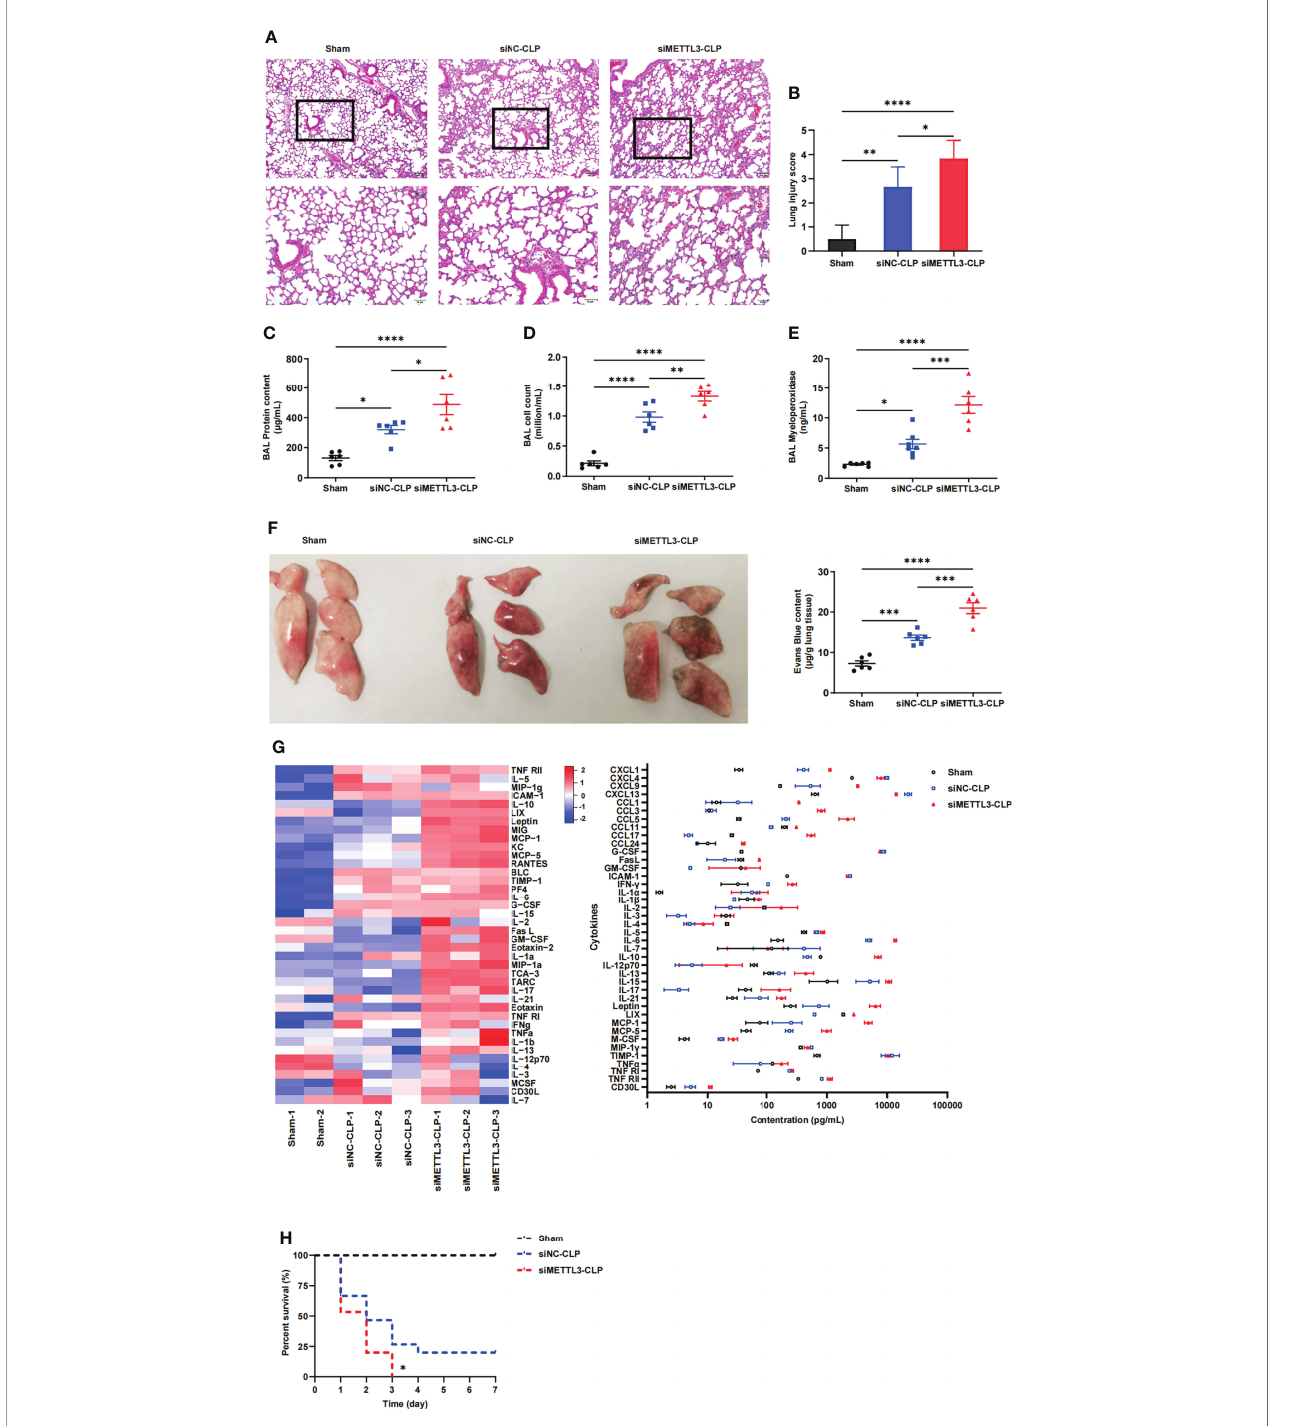
FIGURE 2 | METTL3 deletion exacerbates lung endothelial injury in CLP models. (A) Hematoxylin and eosin (H&E)-stained lung sections from sham, CLP-NC siRNA and CLP-METTL3 siRNA mice. Scale bars, 100 m m. (B) Pathological lung injury scores of sham, CLP-NC siRNA and CLP-METTL3 siRNA mice. (C – E) Protein content (C) , cell counts (D) and MPO activity (E) in the BALF of CLP-METTL3 siRNA mice compared with sham and CLP-NC siRNA mice. (F) Whole lung images and Evans blue levels in sham, CLP-NC siRNA and CLP-METTL3 siRNA mice. (G) Quantibody Mouse In fl ammation Array analysis of circulating blood from sham, CLP-NC siRNA and CLP-METTL3 siRNA mice. (H) Survival analysis of CLP-METTL3 siRNA mice compared with sham and CLP-NC siRNA mice. All data are expressed as the mean ± SD of three independent experiments (n=6 for A-G and n=15 for H). * p < 0.05; ** p < 0.01; *** p < 0.001; **** p <